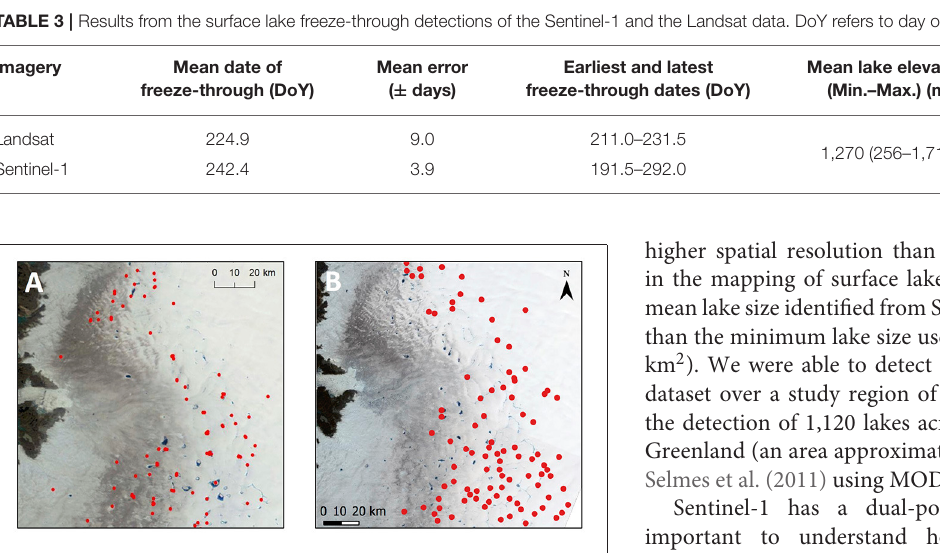
(all above 1,725 m) were never visible in the Landsat imagery. The rest were partially visible in the Landsat data because of melting around their perimeters (e.g., Figure 5 ), which was detected